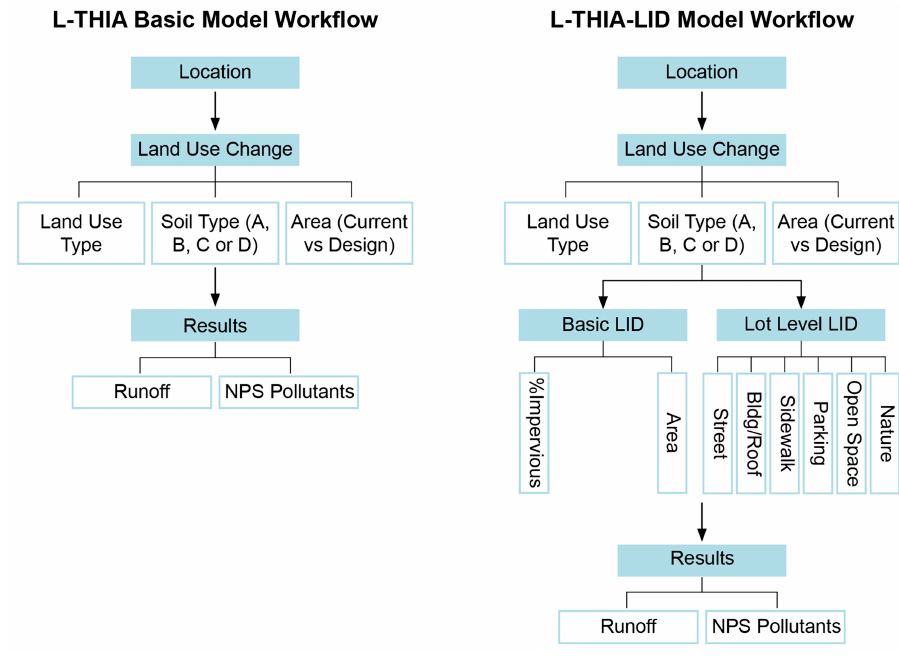
Figure 1. L-THIA and L-THIA-LID models.